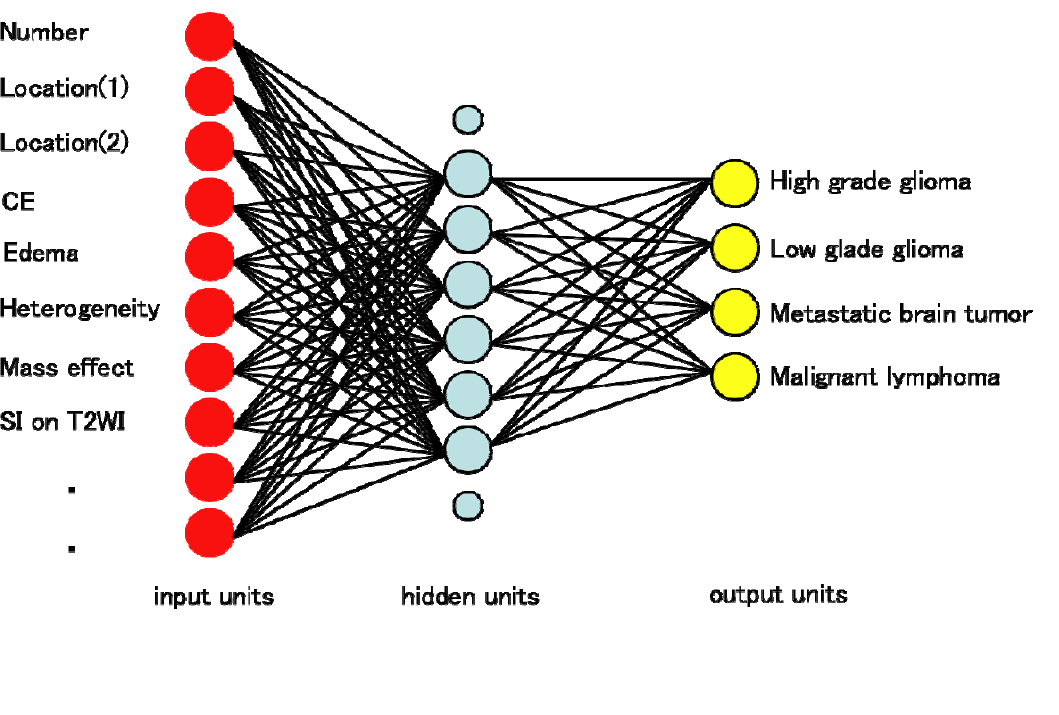
Figure 9. An ANN classifier for differentiating cerebral tumors into 4 categories, which was composed of 15 input units and 4 output units